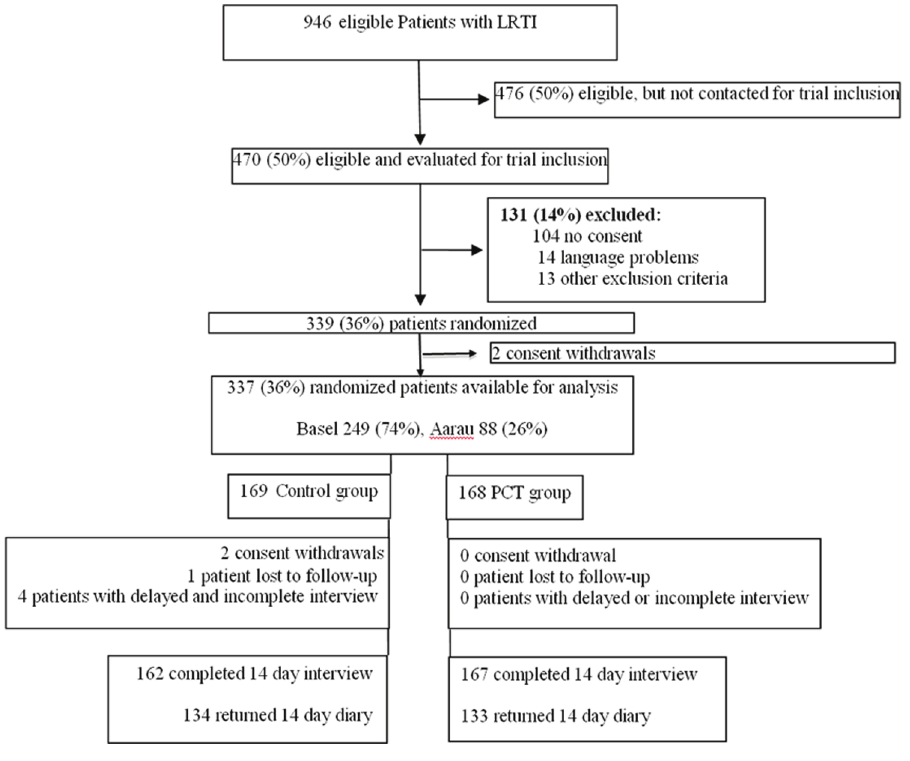
Figure 1. Trial profile.